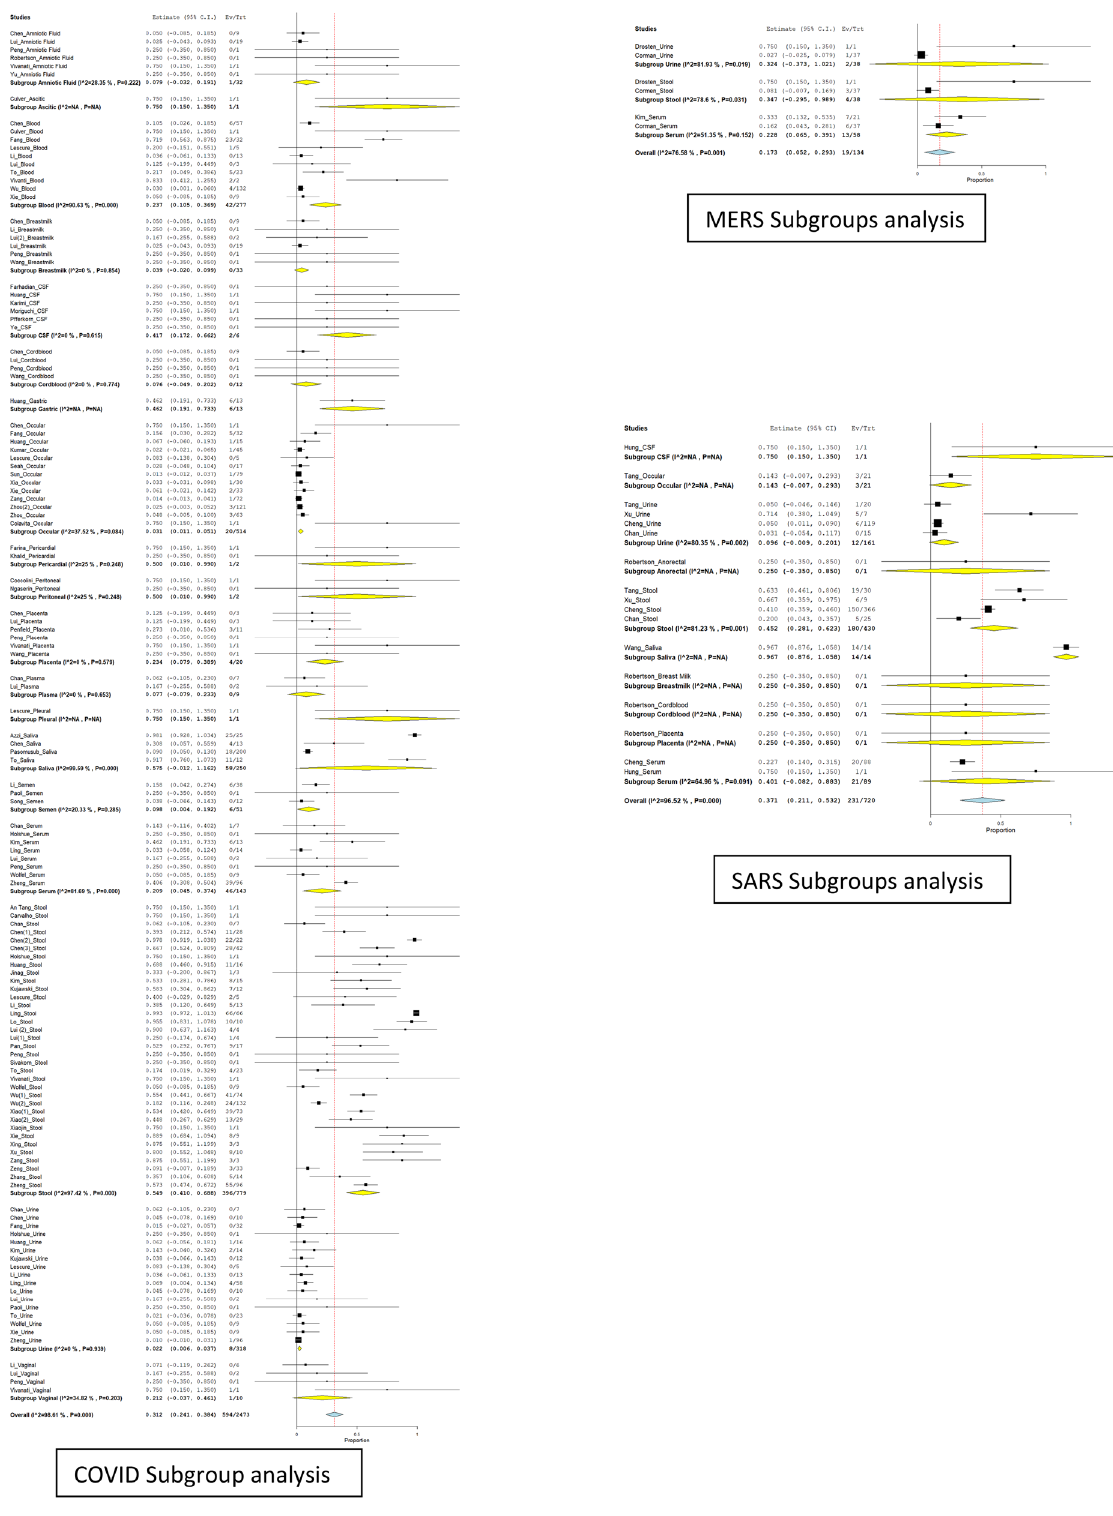
Figure 2. Forest plot of Sub group analysis for Heterogeneity in the analysed studies using Cochrane Q-statistic test and I 2 statistic on different types of clinical